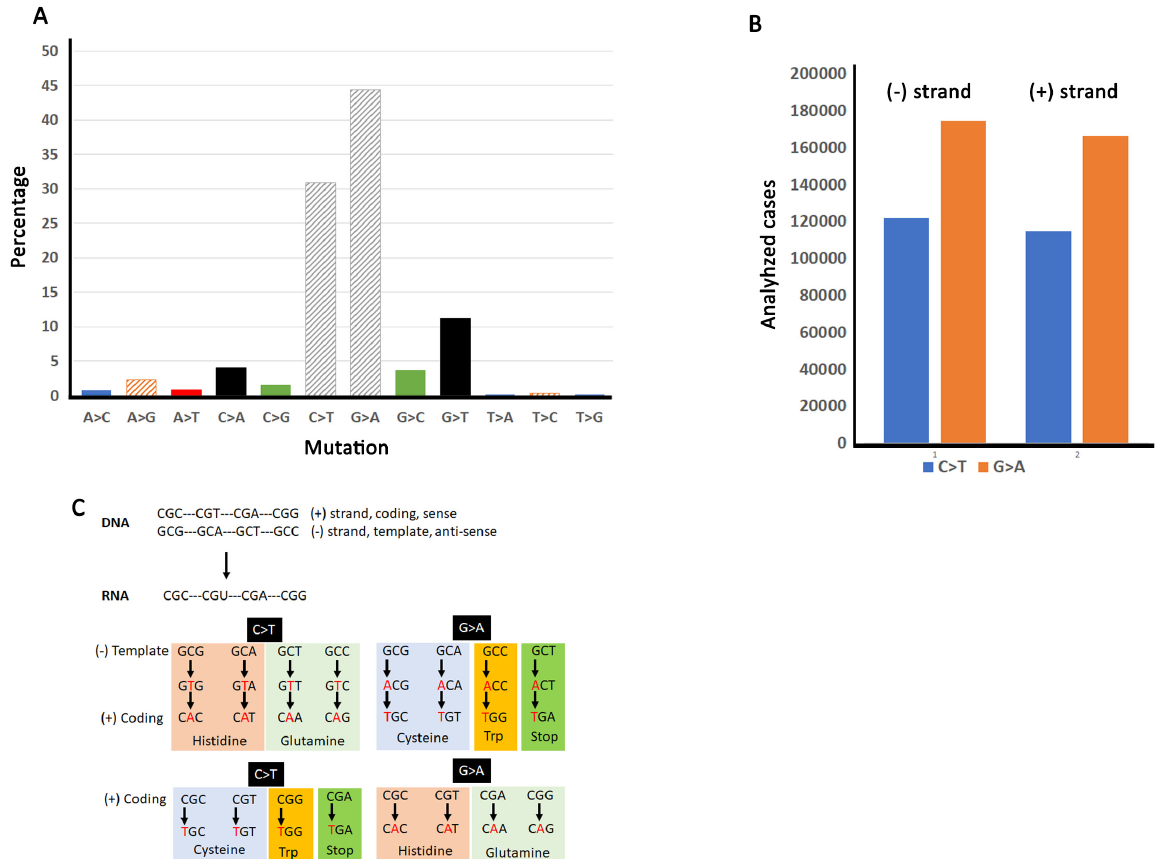
Figure 2. C/G > T/A transitions are responsible for over 75% of all arginine substitutions. ( A ) Percent of each base pair change in the COSMIC V94 (our analysis). For this analysis, the six COSMIC signatures were split into 12 to show opposite strand mutations. ( B ) Strand specific frequencies of C > T and G > A changes. ( C ) Four arginine codons may be responsible for most arginine substitutions. Note that if we consider G > A to be the same as C > T, it is possible to envision how most arginine substitutions could be generated by a C > T transition. In this model, the G > A would become C > T within one round of DNA replication; therefore, the two would look like the same mutation.